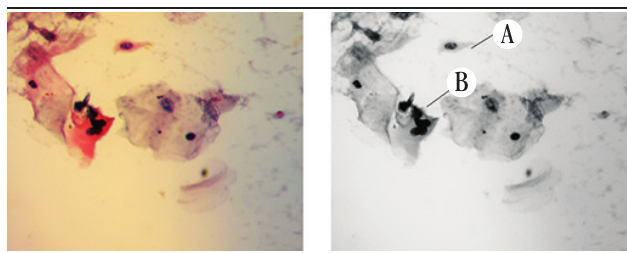
figuRE 1 − Low-grade anal lesion (Papanicolaou stain, 40×), granular background A) parakeratotic cell with enlarged nucleus, beginning karyolysis; B) cluster of atypical cells with dense orangeophilic cytoplasm; visible cell borders; enlarged nuclei irregular in shape, hyperchromatic and binucleated.